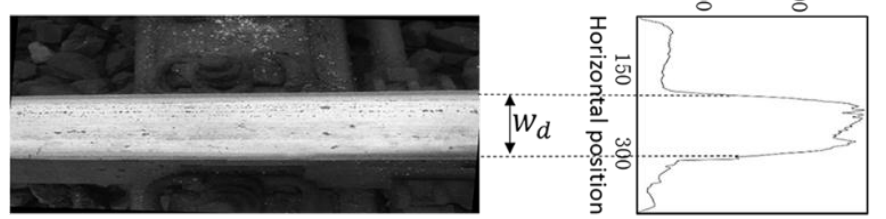
Figure 3. Cumulative gray value of each pixel column for a rail image. Horizontal position denotes location of pixel column.